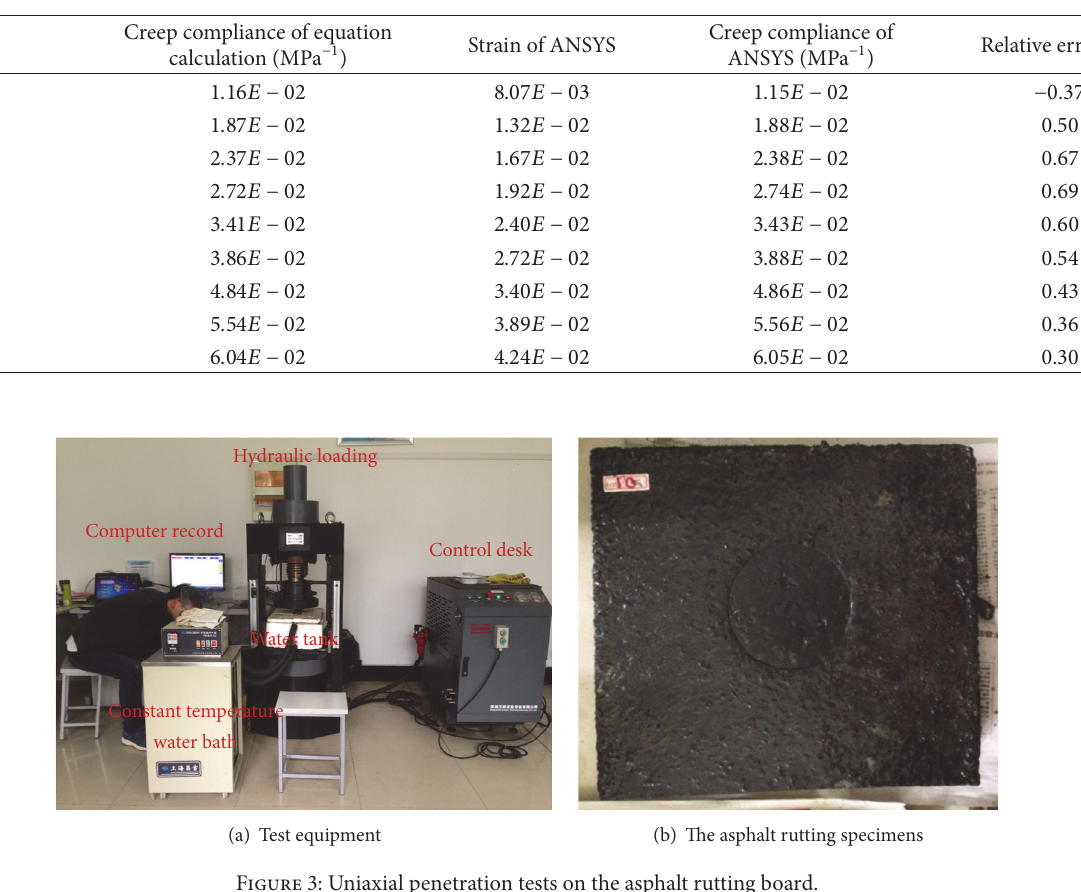
Table 2: The comparison between equation calculation results and the ANSYS simulation.